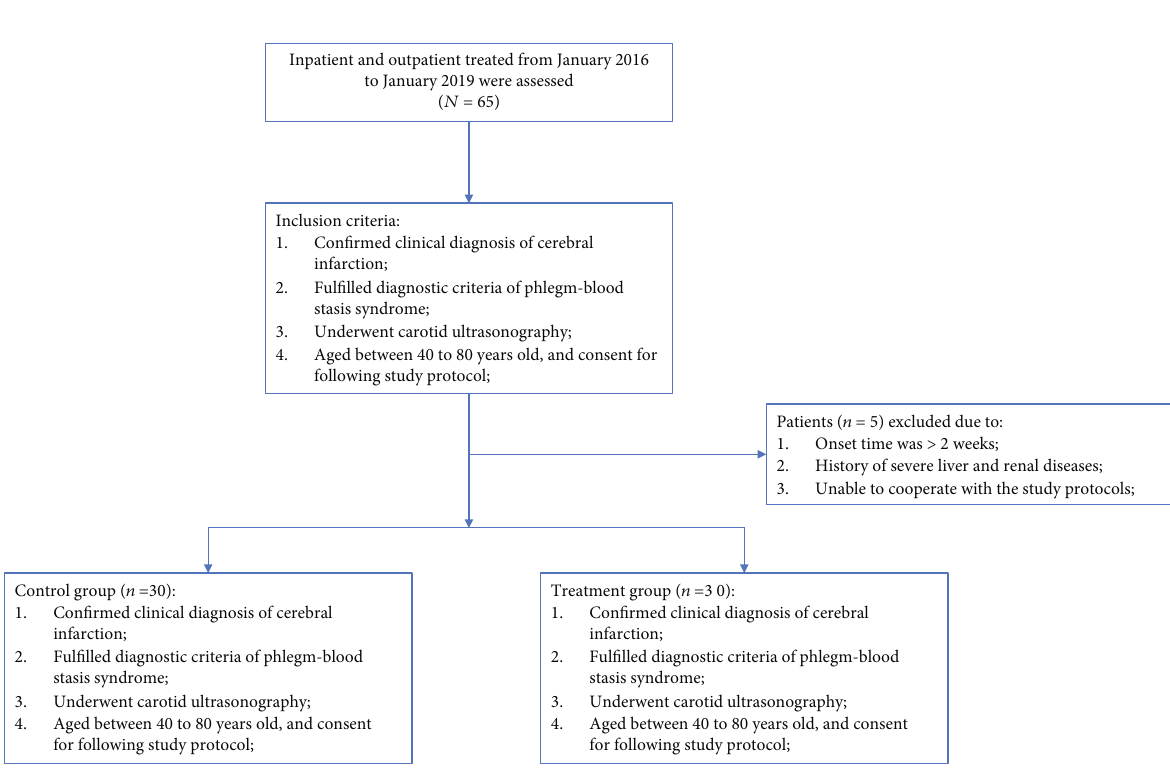
Figure 1: The study fl ow chart. Table 1: Demographic and clinical characteristics of the included cases ( N = 60